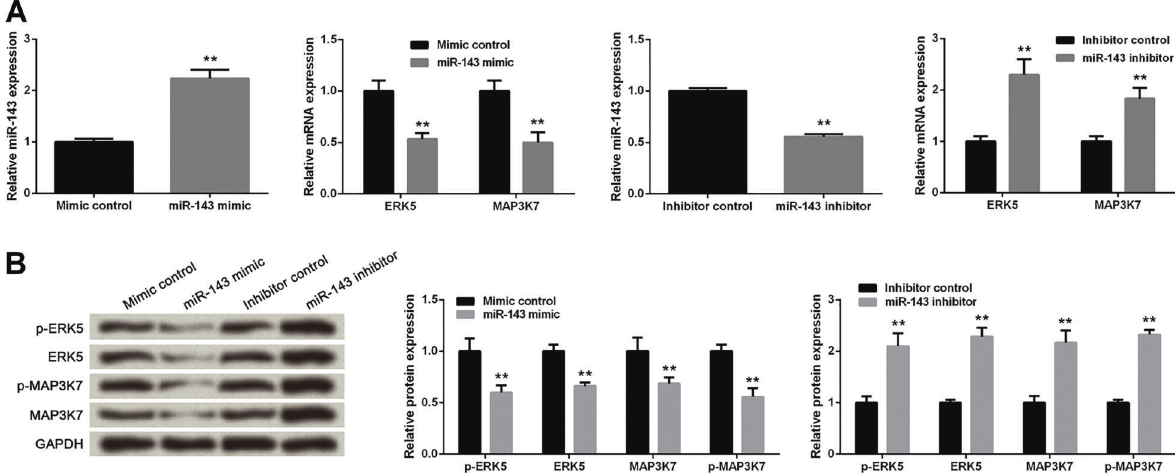
Figure 2. Up-regulated miR-143 decreased expression and phosphorylation of ERK5and MAP3K7 in MCF-7 cells. Cells were transfected with mimic control, miR-143 mimic, inhibitor control or miR-143 inhibitor. A , miR-143 levels and mRNA levels of ERK5 and MAP3K7 using RT-qPCR. B , Expression and phosphorylation levels of ERK5 and MAP3K7 using western blot analysis. ERK5: extracellular signal-regulated kinase 5; MAP3K7: mitogen-activated protein 3 kinase 7. Data are reported as means ± SD of three independent experiments. **P o 0.01 compared with control (ANOVA).